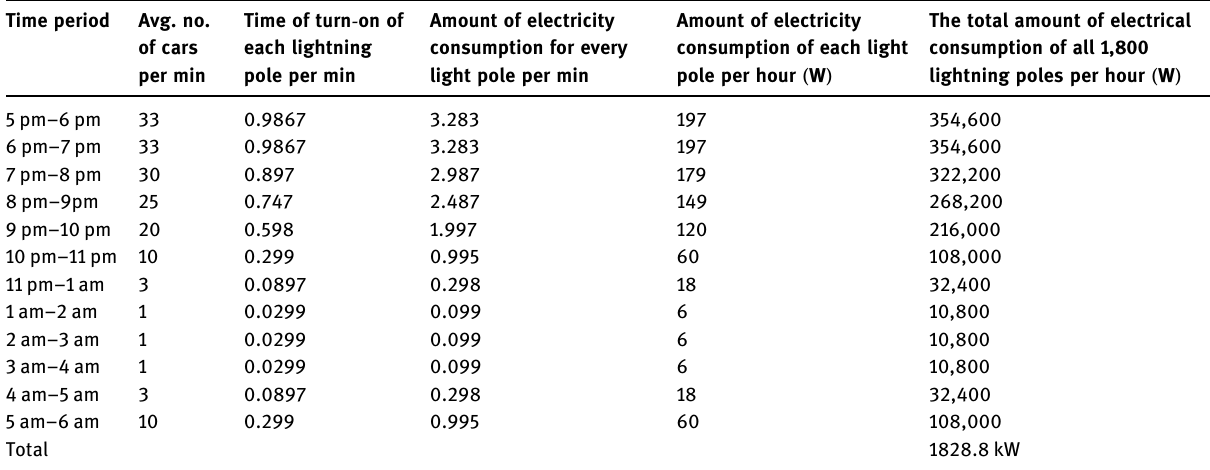
Table 1: Total amount of the energy consumed per lighting pole in every 1 h during the lighting time and the total amount of energy consumed for full time lighting of all the 1,800 poles by using CLS lighting system and HID lighting source Avg. no.